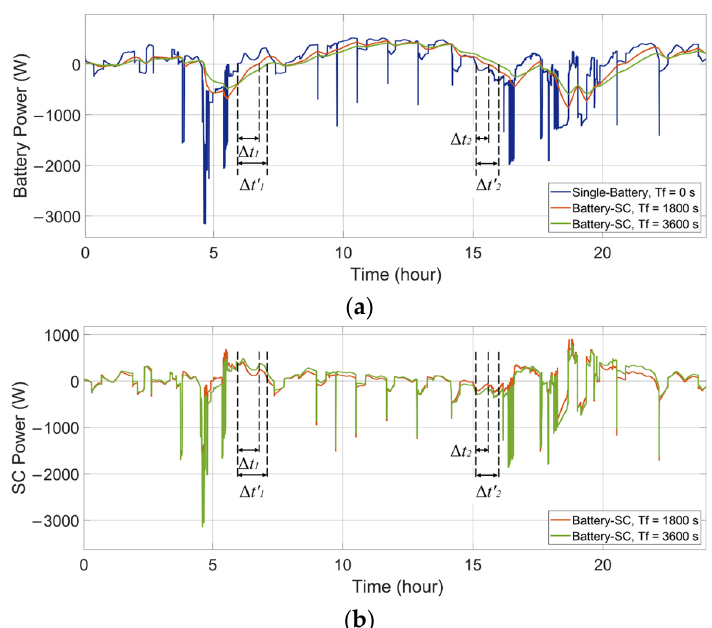
Figure 9. Power flows of the ESDs in the battery-SC HESS with different time constants in a wind- powered household-prosumer system. ( a ) Battery power. ( b ) SC power.